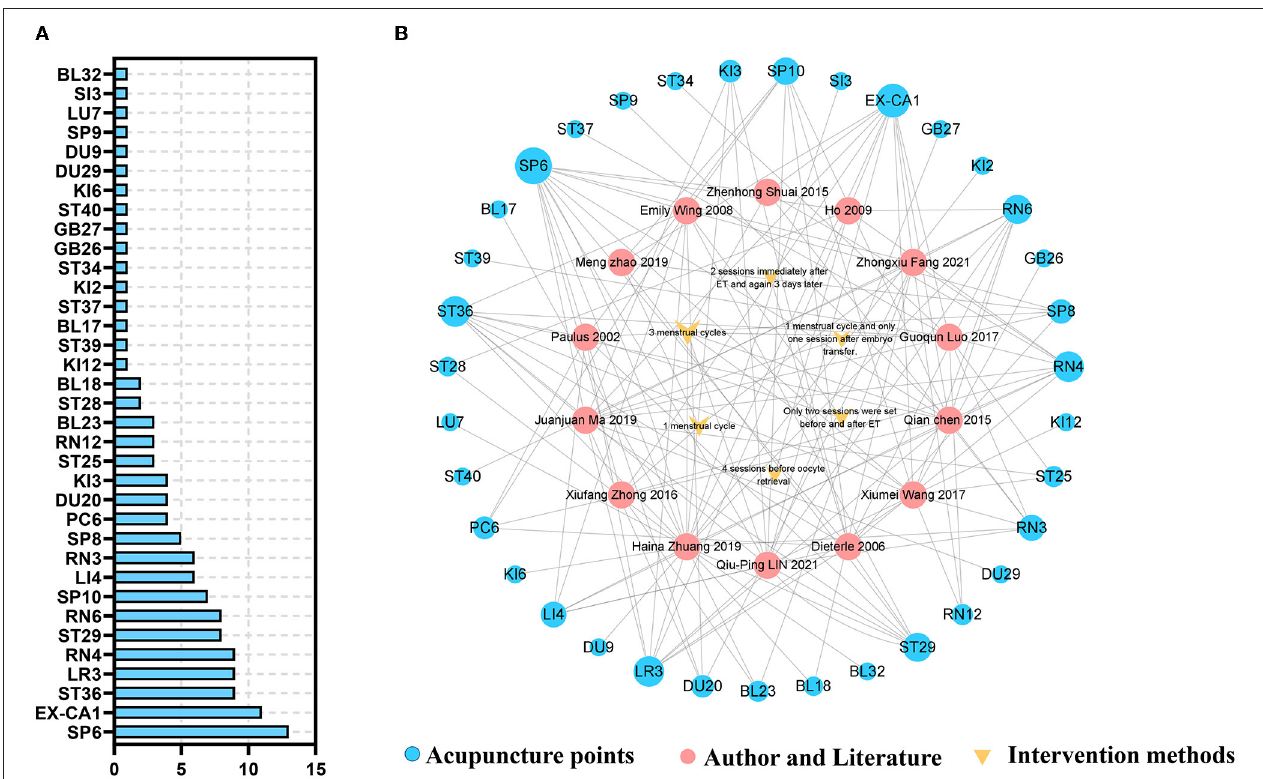
FIGURE 2 | The acupoints and acupuncture duration in included studies. (A) The frequency of acupoints in included studies. (B) The acupoints-associated and duration-associated network construction (The size of each circle or triangle represent the frequency in the studies).